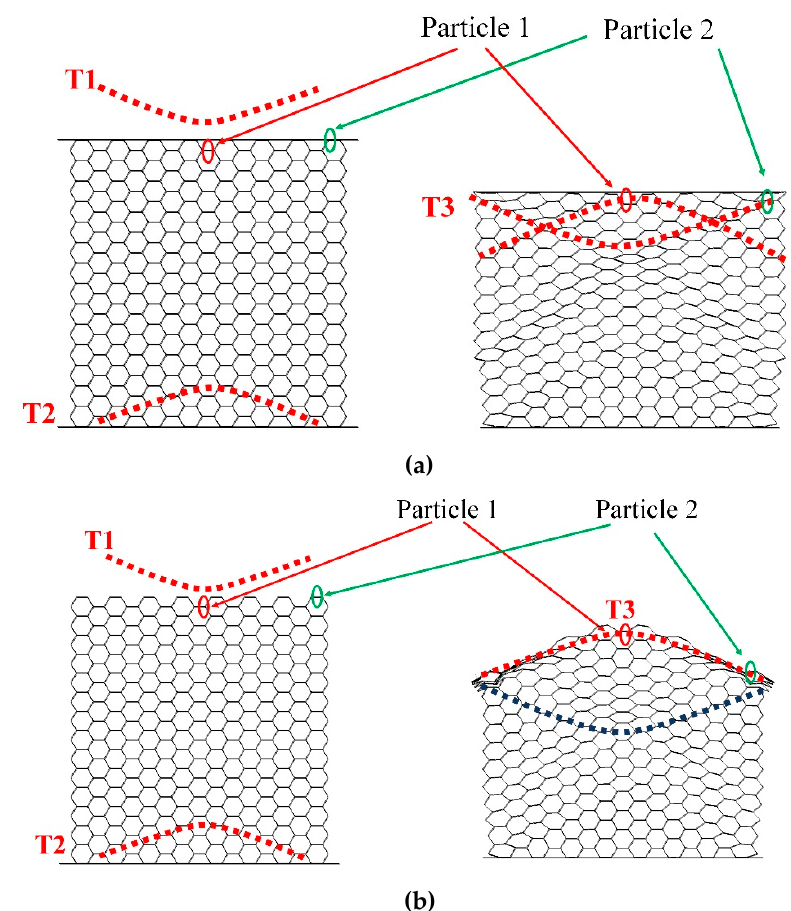
Figure 8. Wave propagation at different moments. (a) RP-H-RP and (b) H-RP.